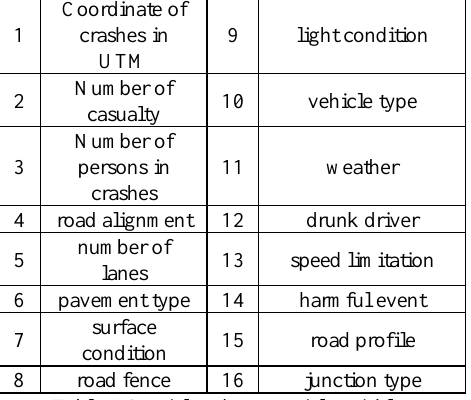
Table 1.Spatial and nonspatial